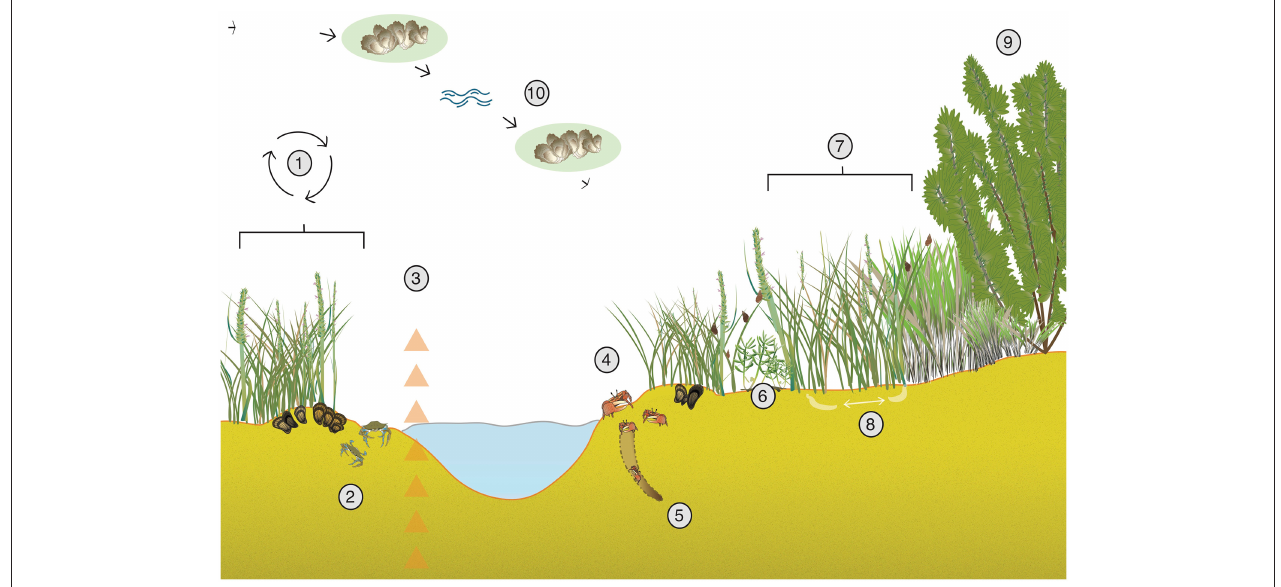
FIGURE 1 | Examples of positive interactions in salt-marsh ecosystems. (1) Mussels provide nutrients to marsh grasses, reduce sulfide stress (Derksen-Hooijberg et al., 2018 ), enhance biodiversity (Angelini et al., 2015), and increase marsh resistance to drought (Angelini et al., 2016). Cordgrass facilitates mussel establishment (Bertness and Grosholz, 1985) and reduces heat stress (Angelini et al., 2015). (2) Predators such as blue and green crabs act as important top-down controls on herbivores and help prevent run-away grazing on marsh grasses ( Silliman and Bertness, 2002; Bertness and Coverdale, 2013). (3) High densities of salt-marsh plants increase wave attenuation, promote sedimentation, and thus increase sediment accumulation (Borsje et al., 2011). (4) Fiddler crabs can mitigate stress caused by snail grazing ( Gittman and Keller, 2013) and the facultative effect of mussels and fiddler crabs can be increased when present together (Hughes et al., 2014). (5) Fiddler crab burrowing can increase oxygen in marsh sediments ( Bertness, 1985). Further, crab burrowing can faciliate mycorrhizal fungi, which can account for ∼ 35% of plant growth (Daleo et al., 2007). (6) Biodiverse assemblages increase biomass and nitrogen accumulation (Callaway et al., 2003). (7) Marsh grasses mixed with other plants can provide a refuge for snails from predators and indirectly protect grasses from grazing ( Hughes, 2012). (8) Close by marsh grasses can help reduce communal stress as they provide shade (Whitcraft and Levin, 2007) and oxygen to sediments (Howes et al., 1986). (9) Spartina alterniflora can act as a nurse plant for other species ( Egerova et al., 2003). (10) Salt marshes provide nutrients to neighboring ecosystems (van de Koppel et al., 2015) and long-distance facilitation from nearby systems such as oyster reefs can reduce wave stress ( Meyer et al., 1997). See acknowledgments for vector